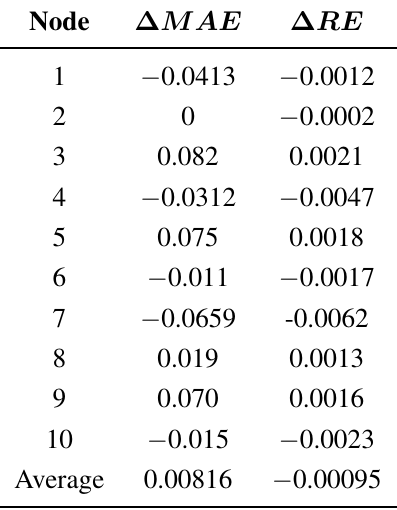
Figure 11. Relative update rate ( R ) of SWIFTNET taken from 10 nodes. update Performance summary of SWIFTNET: Result from 10 nodes, ∆ MAE and ∆ RE represent the relative accuracy differences for SWIFTNET compared with the default adaptive prediction method, where “ − ” signifies that SWIFTNET has a lower